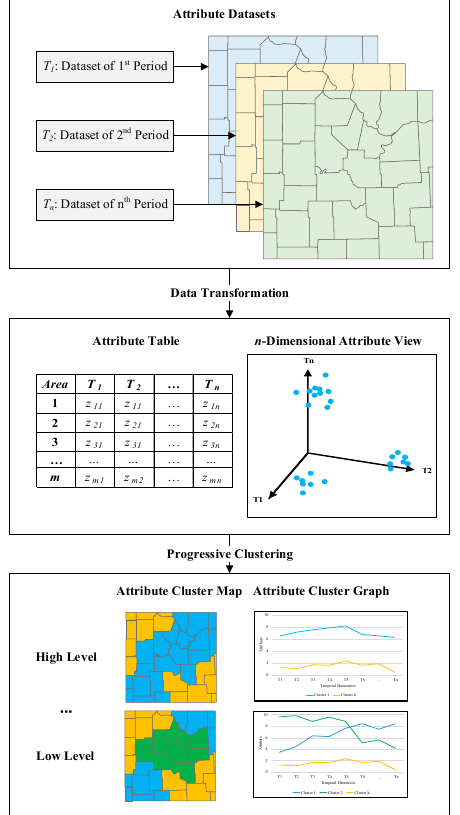
Figure 1. The general framework of the Spatial-Temporal Indication of Crime’s Association (STICA). Firstly, datasets for a specific attribute of a particular geographic phenomenon in dif- ferent periods are created. Such datasets are typically area-based vectors or raster data.